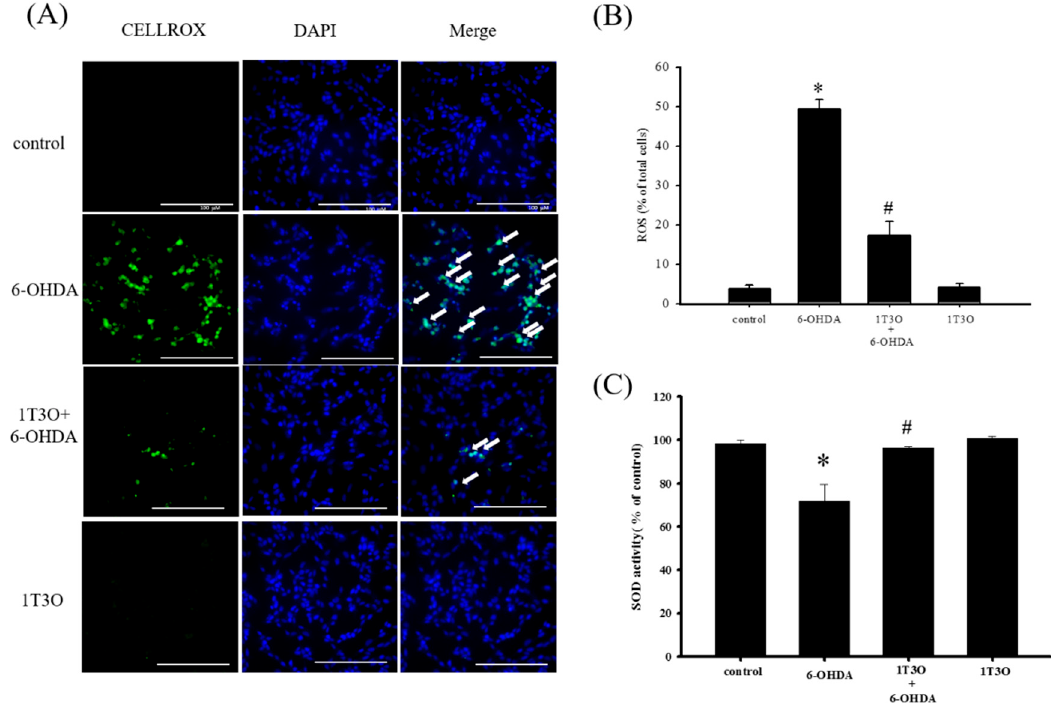
Figure 6. Effect of 1T3O on 6-OHDA-induced elevation in cellular ROS and decrease in superoxidase dismutase (SOD) activity. ( A ) Shows the use of CellROX ® stain as a specific fluorescent probe for intracellular ROS to detect intracellular oxidative stress. Green fluorescence represents bounded CellROX ® stain and blue fluorescence represents DAPI-dyed cell nuclei. Arrows indicate the ROS generated in cells. ROS level was shown as ( B ); ( C ) represents the use of the SOD activity assay kit to quantitate intracellular SOD activity and study the effect of 1T3O (1 μ M) on 6-OHDA-induced (20 μ M) reduction in SOD activity. Results show that 1T3O can attenuate 6-OHDA-induced ROS elevation and SOD activity reduction. Data are presented as mean ± SEM. (* p < 0.05 vs. Control; # p < 0.05 vs. 6-OHDA group).